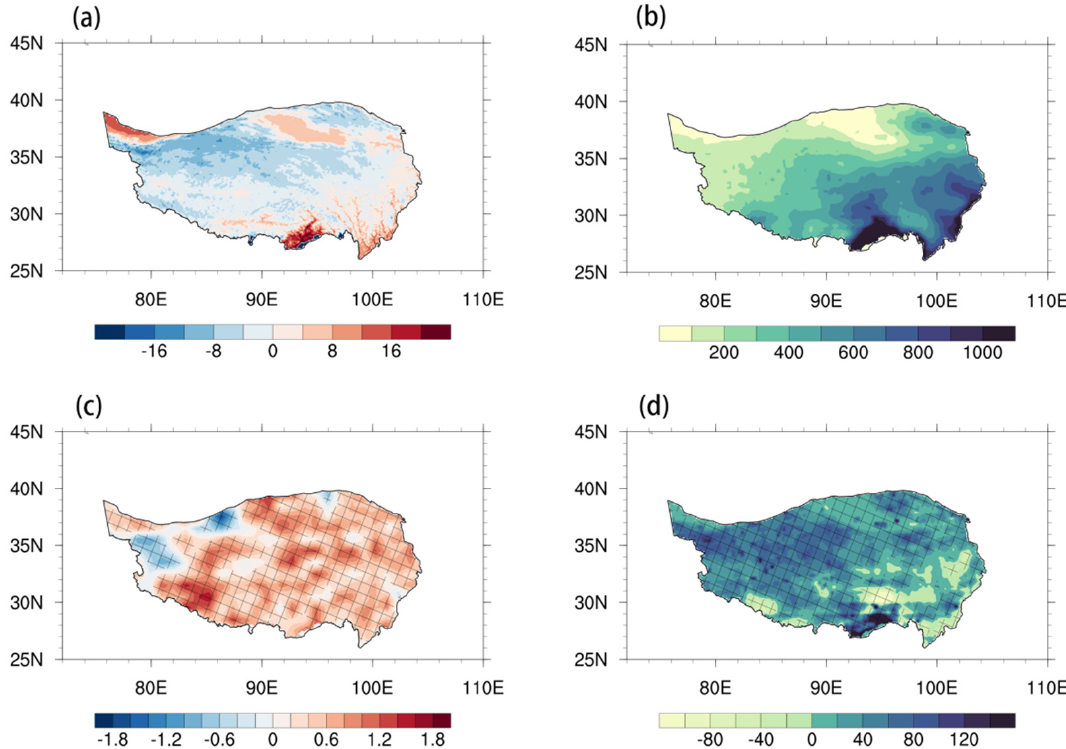
Figure 3. Climatology and trends in temperature and precipitation on the TP from 1980 to 2016. ( a ) Climatology of temperature (unit: ◦ C). ( b ) Climatology of precipitation (unit: mm). ( c ) Trend in temperature (unit: ◦ C/decade). ( d ) Trend in precipitation (unit: mm/decade). Grid points with statistically significant anomalies at the 90% confidence level are denoted by an oblique line.